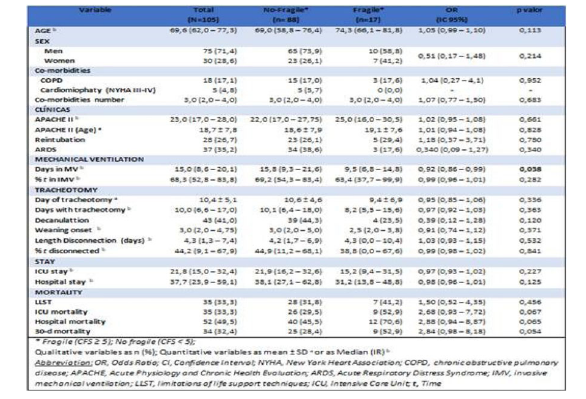
Table 1 (abstract 001051). See text for description